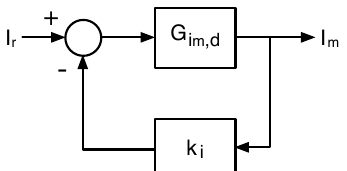
Figure 2. Current loop based on a proportional